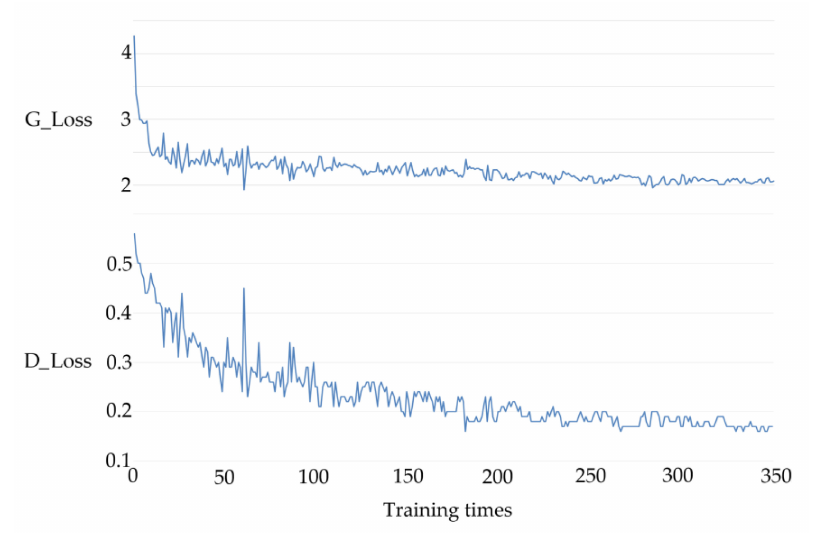
Figure 5. Training loss for